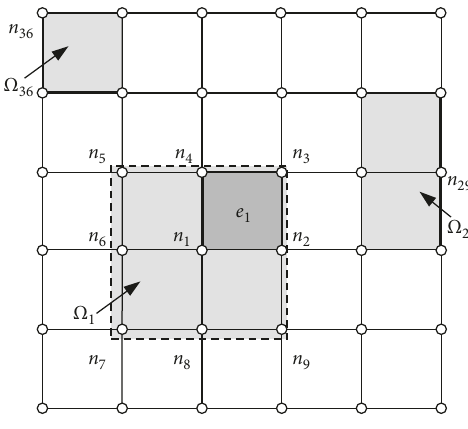
Figure 1: Nodal support